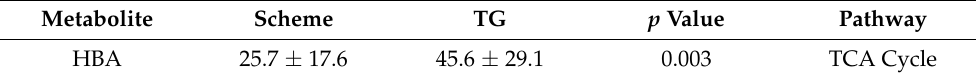
Table 2. Metabolite differences (conc in uM) between treatment groups. p value from paired T